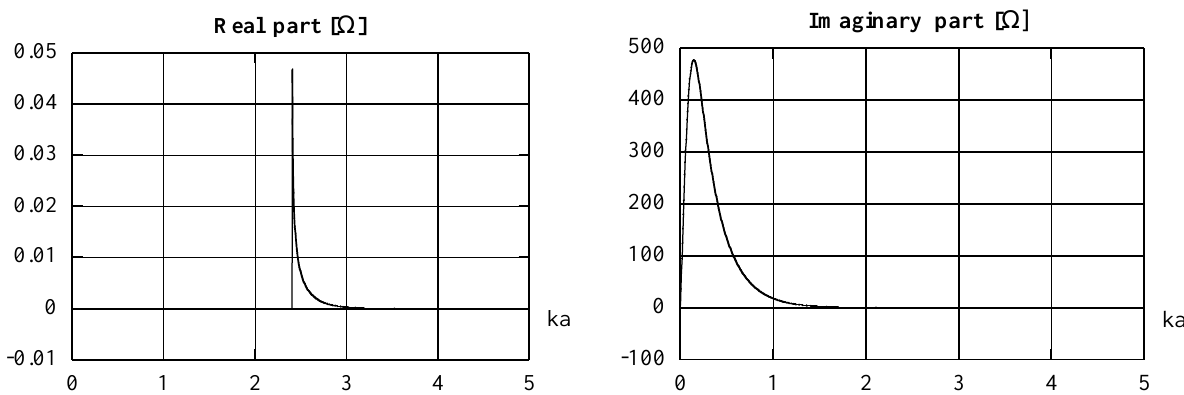
FIG. 5. Real and imaginary parts of the longitudinal coupling impedance in the case (cid:119) (cid:173) (cid:49) (cid:121) (cid:53) and bg (cid:173) (cid:49) (cid:121) (cid:49)(cid:48)